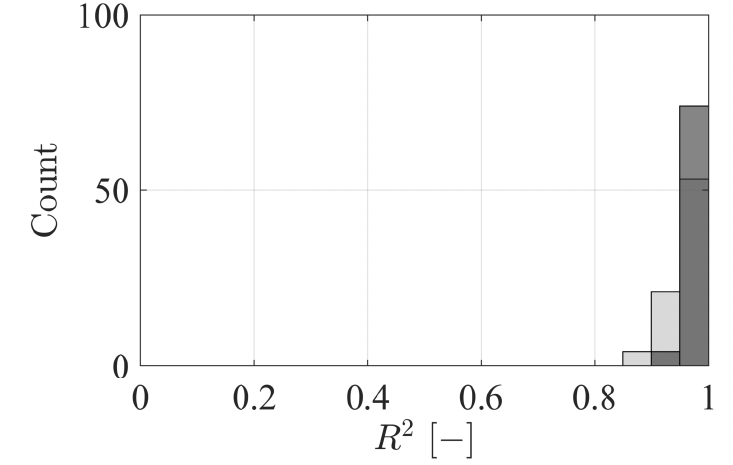
Figure 9. Histogram of the coefficients of determination for the time domain ( R 2 frequency domain ( R 2 , dark) for the forces reconstructed using the method described in Section 2.2 f and single-step load pattern in Model